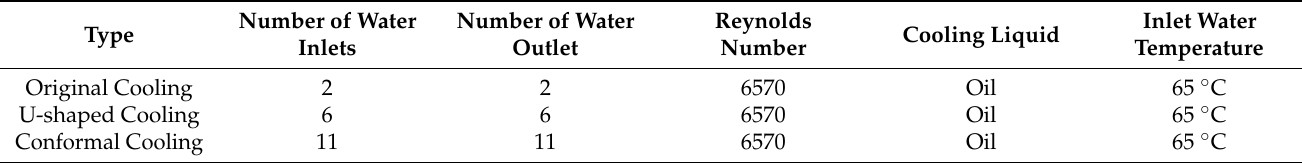
Figure 6. Cooling Configurations. ( a ) Original cooling. ( b ) U-shaped cooling. ( c ) Conformal cooling. Table 5. Comparison of Different Water Cooling Systems.